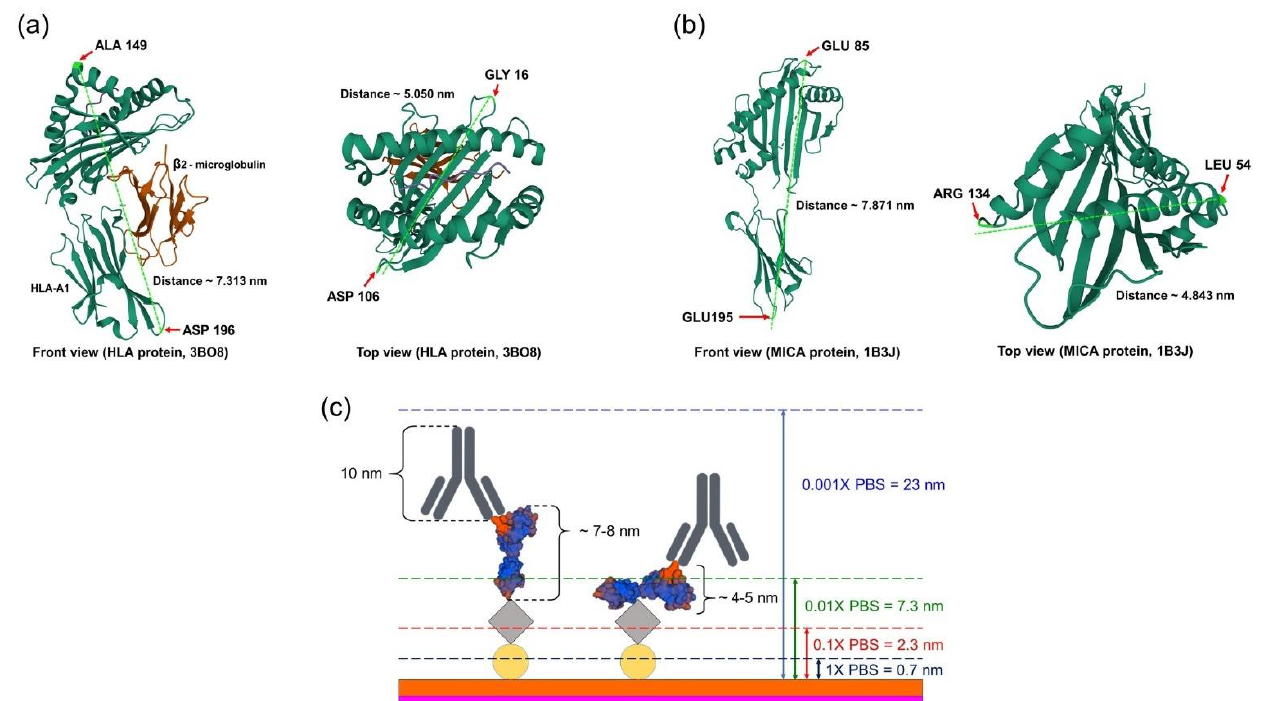
Figure 6. The schematic represents the size of proteins and the length of λ D in different concentra- tions of PBS at room temperature . ( a ) The size of HLA proteins ( PDB code : 3BO8 ) ; the longest di- of PBS at room temperature. ( a ) The size of HLA proteins (PDB code: 3BO8); the longest dimension mension was determined as between 149 ( ALA ) and 196 ( ASP ) , while the widest dimension was was determined as between 149 (ALA) and 196 (ASP), while the widest dimension was determined determined as between 16 ( GLY ) and 106 ( ASP ). ( b ) The size of MICA proteins ( PDB code : 1B3J ) ; as between 16 (GLY) and 106 (ASP). ( b ) The size of MICA proteins (PDB code: 1B3J); the longest the longest dimension was determined as between 85 ( GLU ) and 195 ( GLU ) , while the widest di- dimension was determined as between 85 (GLU) and 195 (GLU), while the widest dimension was mension was determined as between 54 ( LEU ) and 134 ( ARG ). ( c ) The total length of the function- determined as between 54 (LEU) and 134 (ARG). ( c ) The total length of the functionalized surface and alized surface and immunocomplex on the Si 3 N 4 substrate was 19 – 22 nm, compared to the different immunocomplex on the Si 3 N 4 substrate was 19–22 nm, compared to the different λ D, which depends λ D, which depends on the PBS concentrations . on the PBS concentrations.